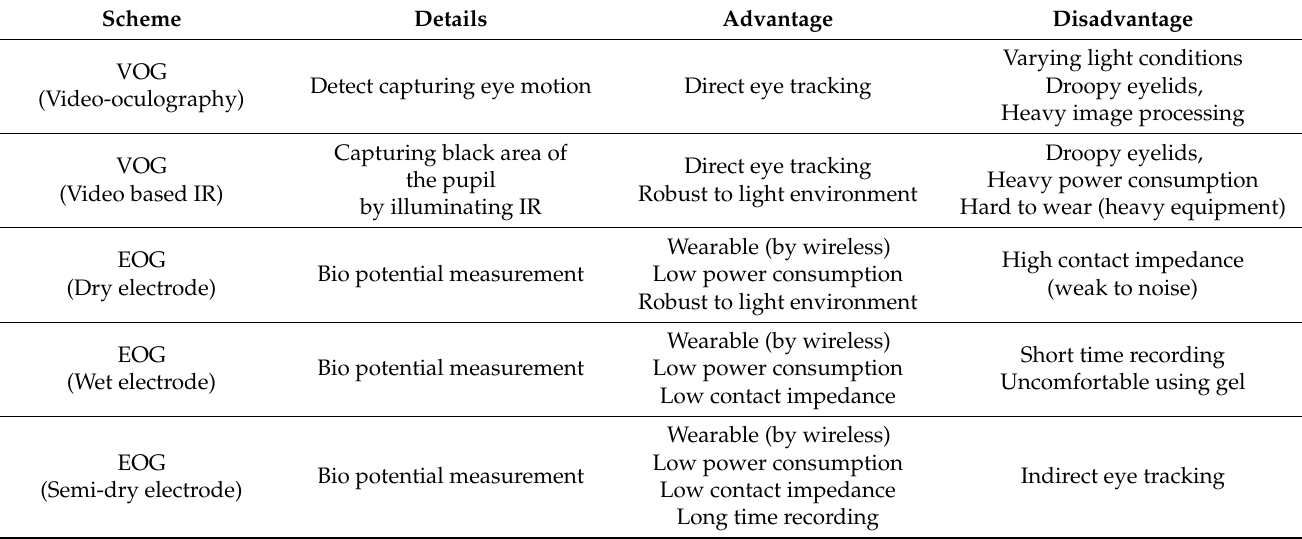
Table A1. Wearable eye movement tracking scheme